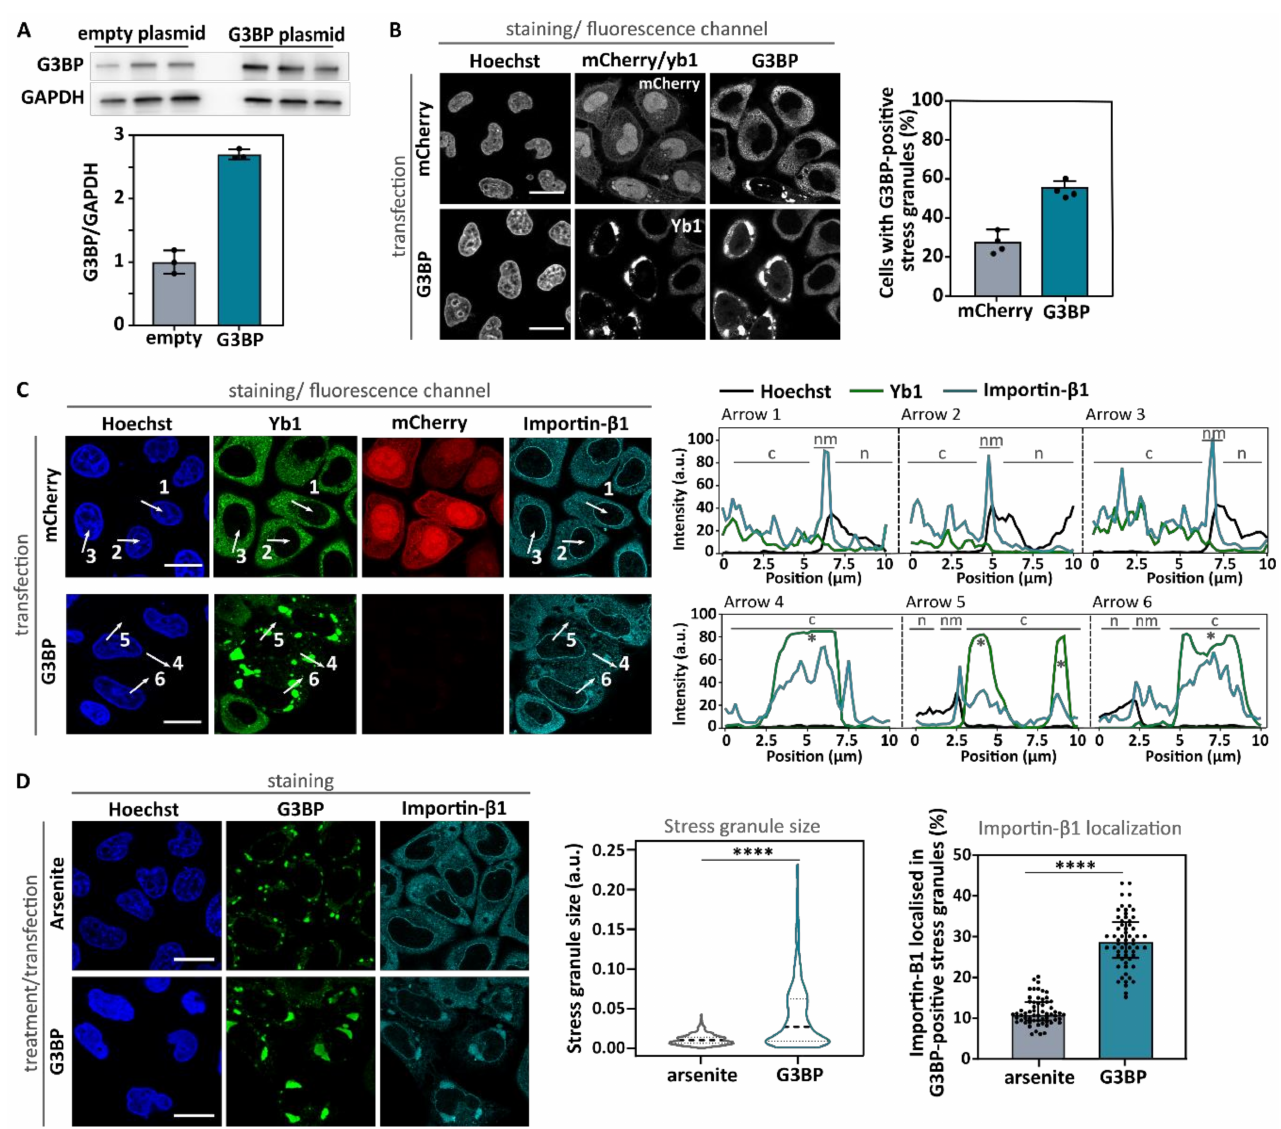
Figure 6. G3BP overexpression results in large stress granules and a strong importin- β 1 co- localization. ( A ). HeLa Kyoto cells were transfected with plasmids expressing mCherry or G3BP1. At 48 h after transfection, G3BP overexpression was determined by Western blot. Relative expressions of G3BP compared to the loading control GAPDH are shown as mean ± SD of three biological replicates. ( B ). Cells transfected with the mCherry or G3BP plasmids were fixed at 48 h after transfection and stained with indicated antibodies. The percentage of cells with stress granules is presented. Each dot is the average of one experiment with 193–292 cells per experiment. Means ± SD. ( C ). Intensity plots confirming colocalization between yb1 and importin- β 1. n = nucleus; nm = nuclear membrane; c = cytoplasm; * = stress granule. Scale bar = 20 µ m. ( D ). Comparison of stress granule size and importin- β 1 localization induced by arsenite treatment or G3BP overexpression. Left graph: Size of stress granules was measured using ImageJ in 75 cells of three experiments (25 cells per experiment). Stress granules were significantly larger in G3BP overexpression cells. Truncated violin plot. Mann– Whitney U test. Right graph: Percentage of importin- β 1 intensity in stress granules compared to the whole cell intensity was manually measured in arsenite-treated cells and G3BP overexpression cells. Significantly more importin- β 1 localized to stress granules in G3BP overexpression cells. Each dot represents one cell with n = 60 from three experiments (20 cells per experiment) . Mann–Whitney U test. Median ± IQR. Scale bar = 20 µ m. **** indicates p <